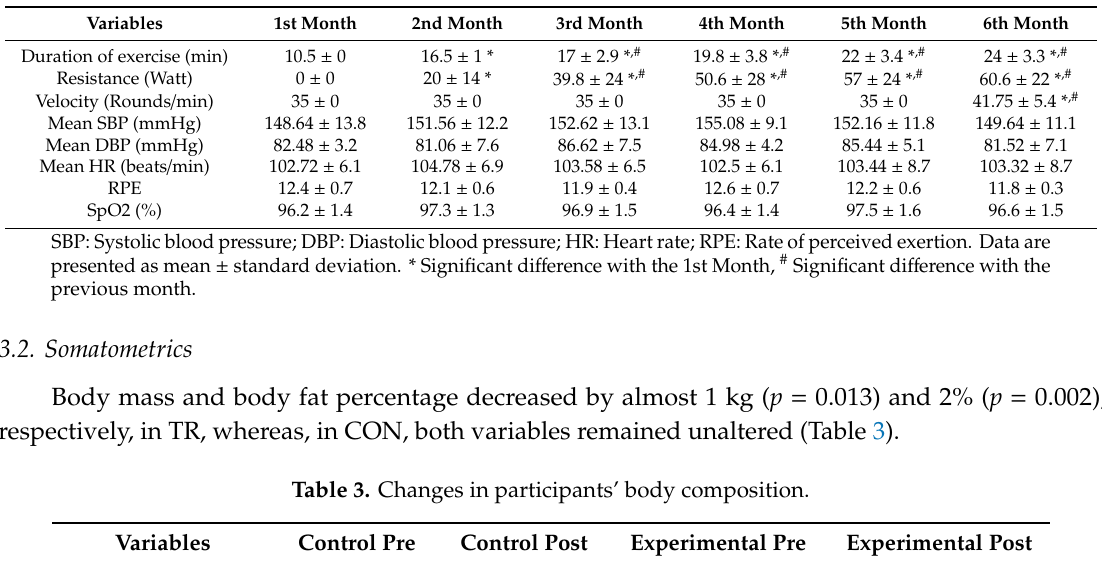
Table 2. Monthly changes in external and internal load during the 6-month intervention.